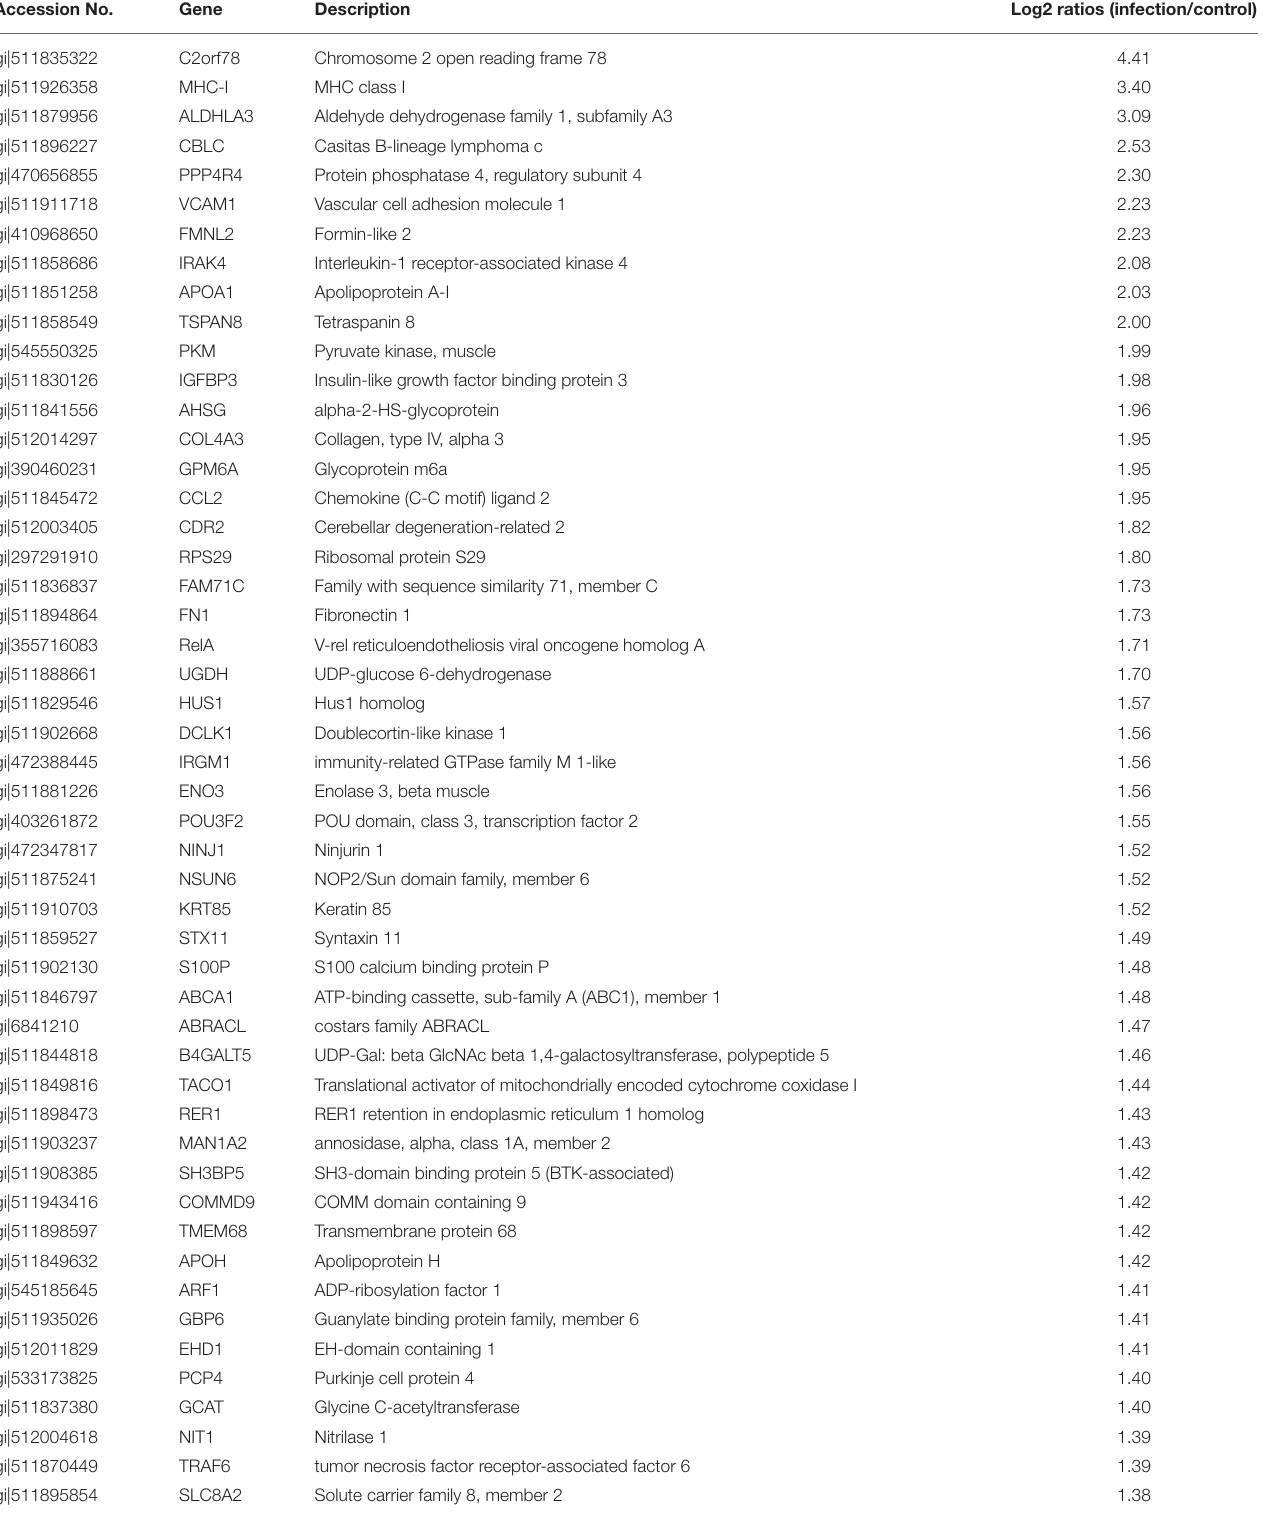
TABLE 2 | Partial differentially expressed proteins in Mv.1.Lu cells infected with PS. Accession